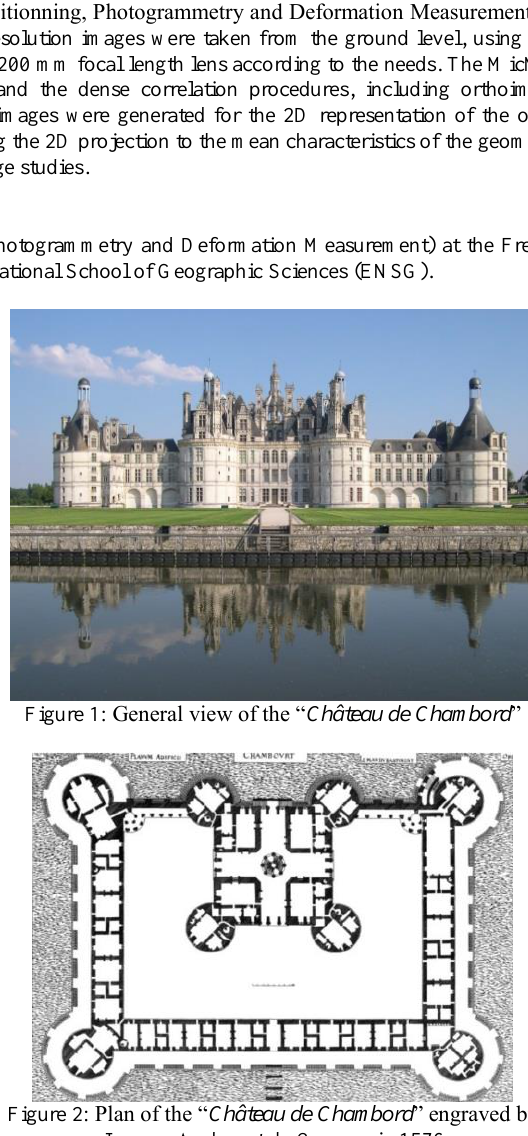
Figure 2: Plan of the “ Château de Chambord ” engraved by Jacques Androuet du Cerceau in